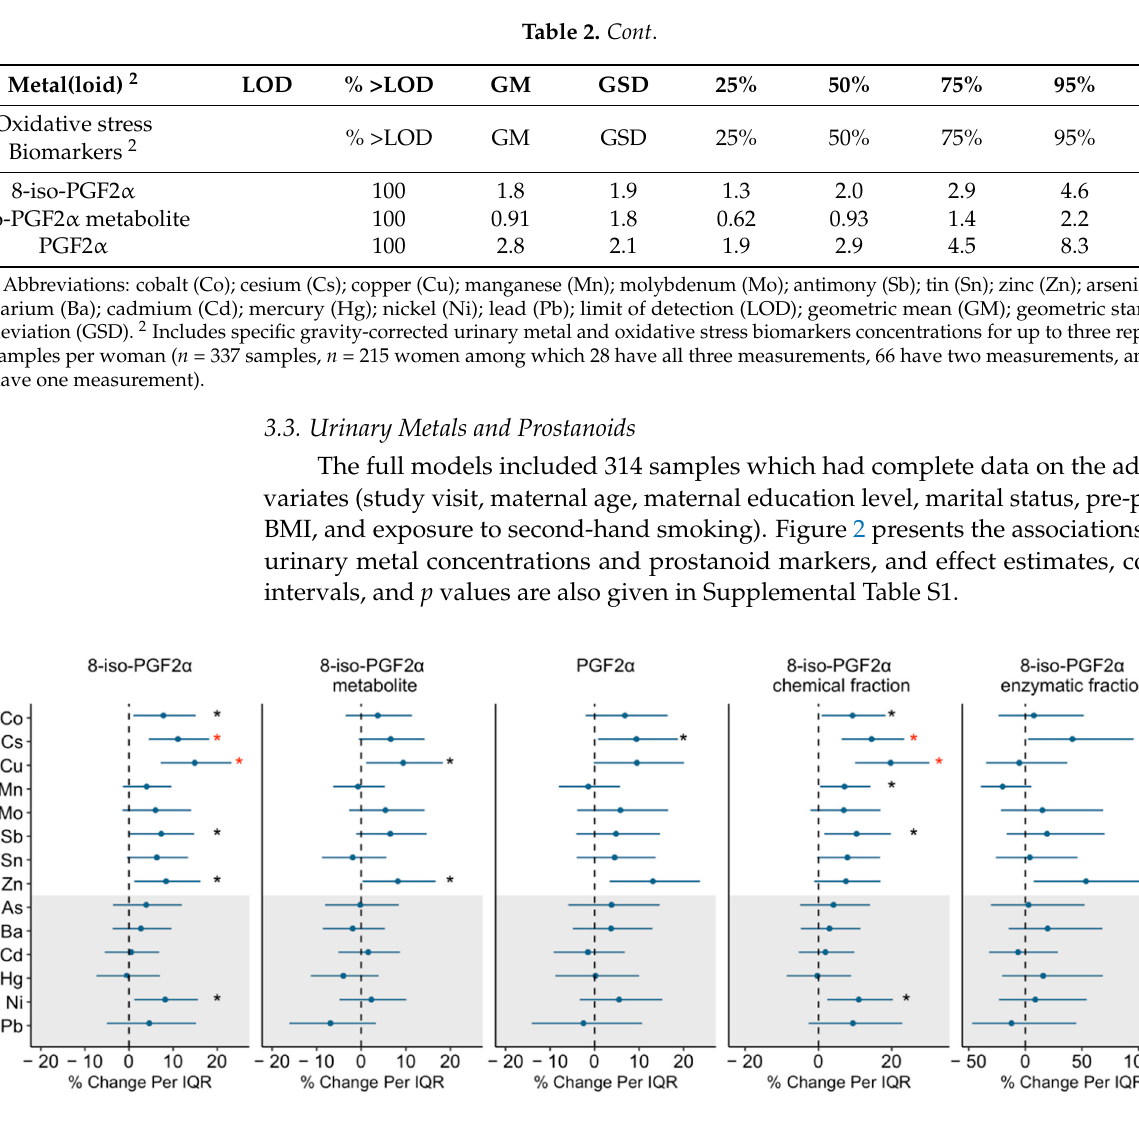
Figure 2 . Percent change in prostanoids associated with urinary metal concentrations. Effect estimates presented as percent change (%) for interquartile range (IQR) increase in exposure biomarker concentration. Models were adjusted for study visit, maternal age, maternal education, marital status, pre-pregnancy BMI, and exposure to secondhand smoking. Abbreviations: cobalt (Co); cesium (Cs); copper (Cu); manganese (Mn); molybdenum (Mo); antimony (Sb); tin (Sn); zinc (Zn); arsenic (As); barium (Ba); cadmium (Cd); mercury (Hg); nickel (Ni); lead (Pb). White shading indicates essential metals and grey shading indicates non-essential metals. Since Cs is not regarded as essential to the health of plants or animals nor does it present a hazard to them, Cs was considered as essential metal for the analysis. Black * denotes p value < 0.05; red * denotes a p value < 0.05 and q value (false discovery rate) <